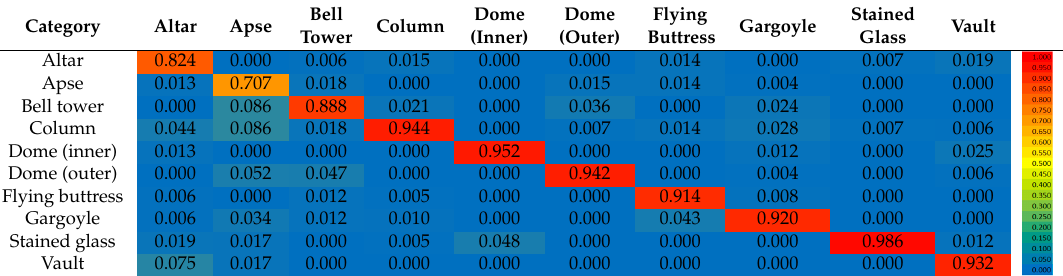
Table 9. Confusion matrix obtained using a ResNet network (full-training) and the test dataset (the rows correspond to the actual values and the columns to the predicted values).